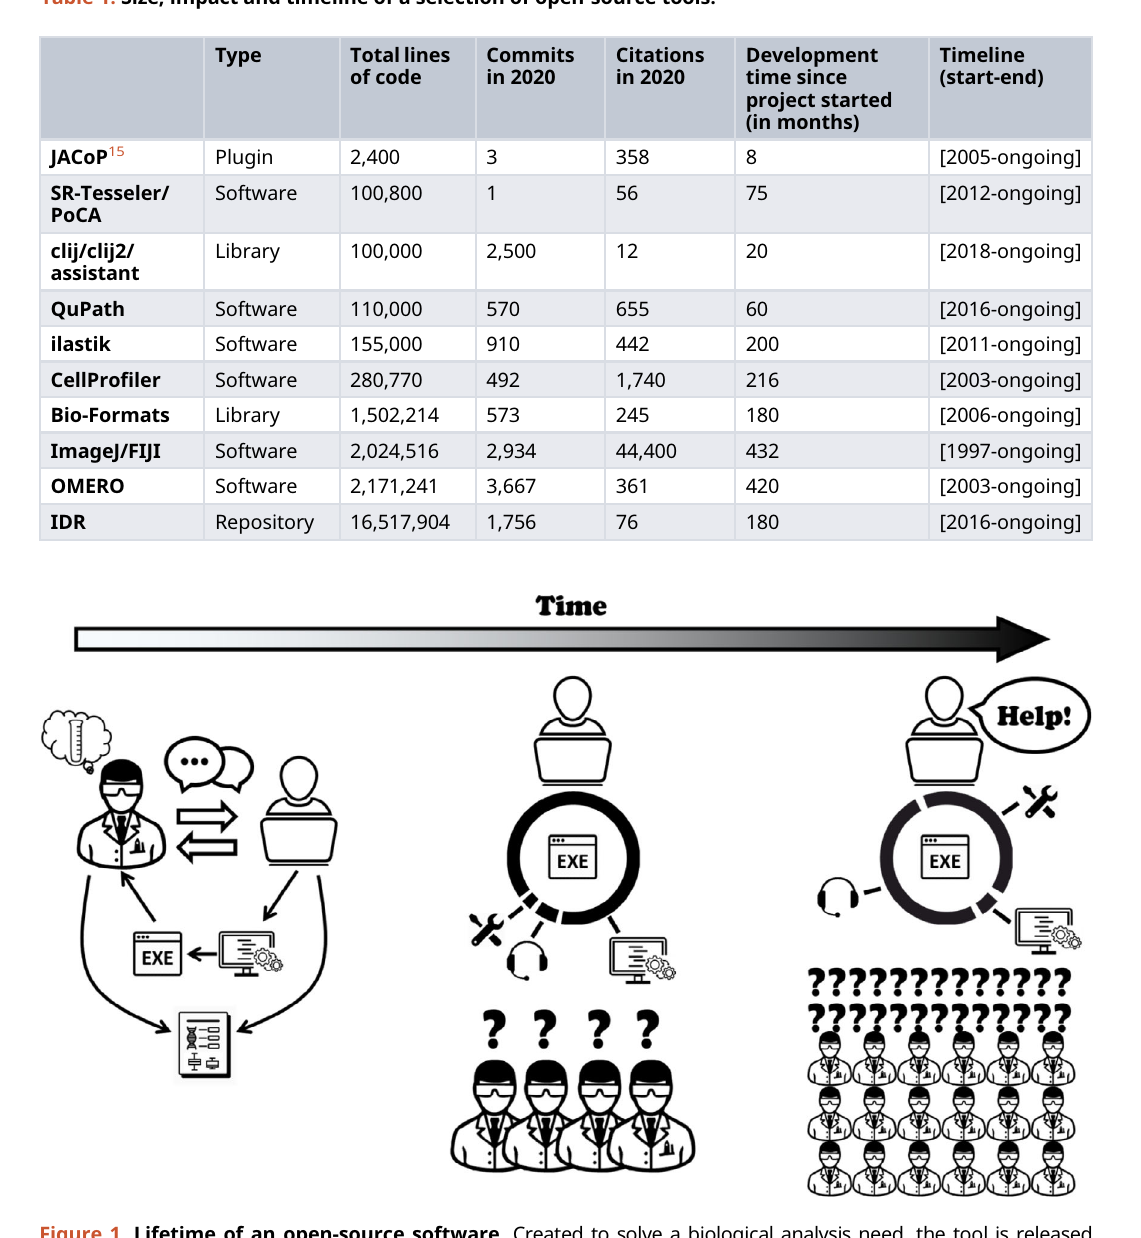
Table 1. Size, impact and timeline of a selection of open-source tools.